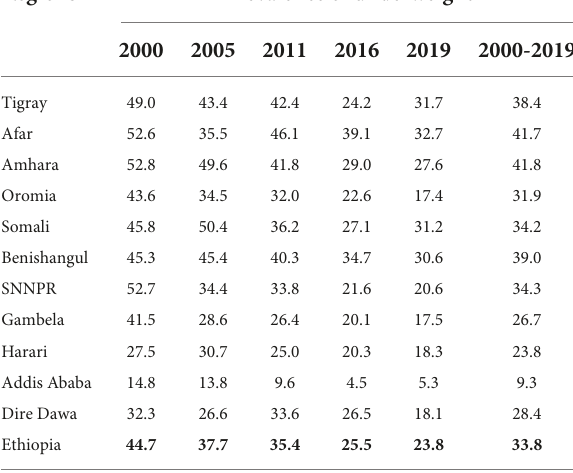
TABLE 1 The national and regional prevalence of underweight among children aged below 5 years in Ethiopia between 2000 and 2019. Regions